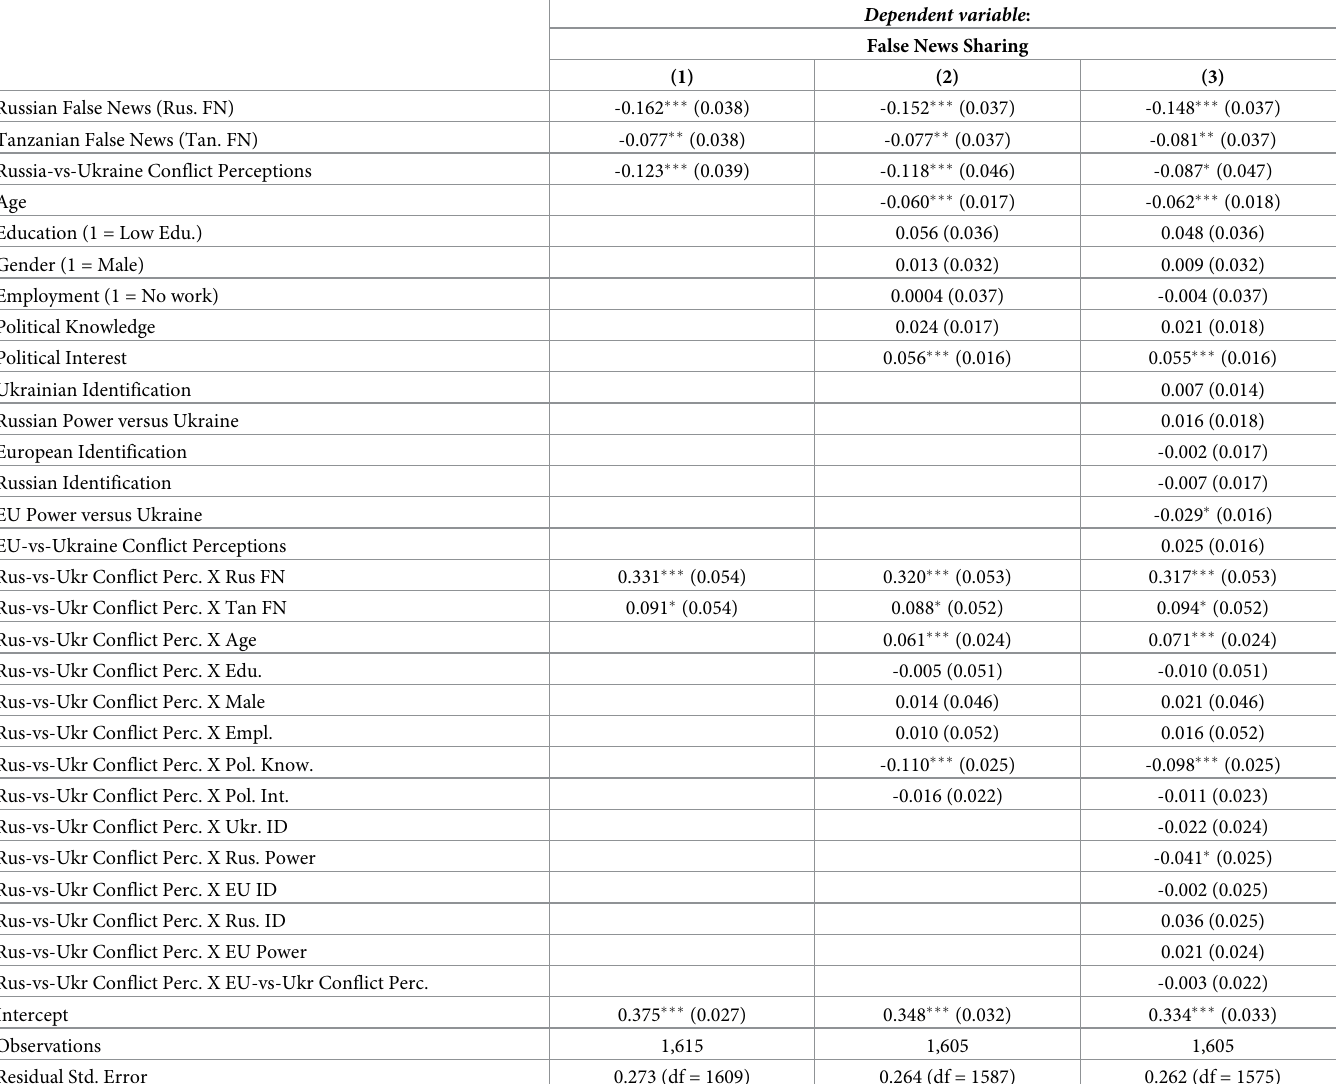
Table 3. Effect of treatment conditions and conflict perceptions on intentions to share false